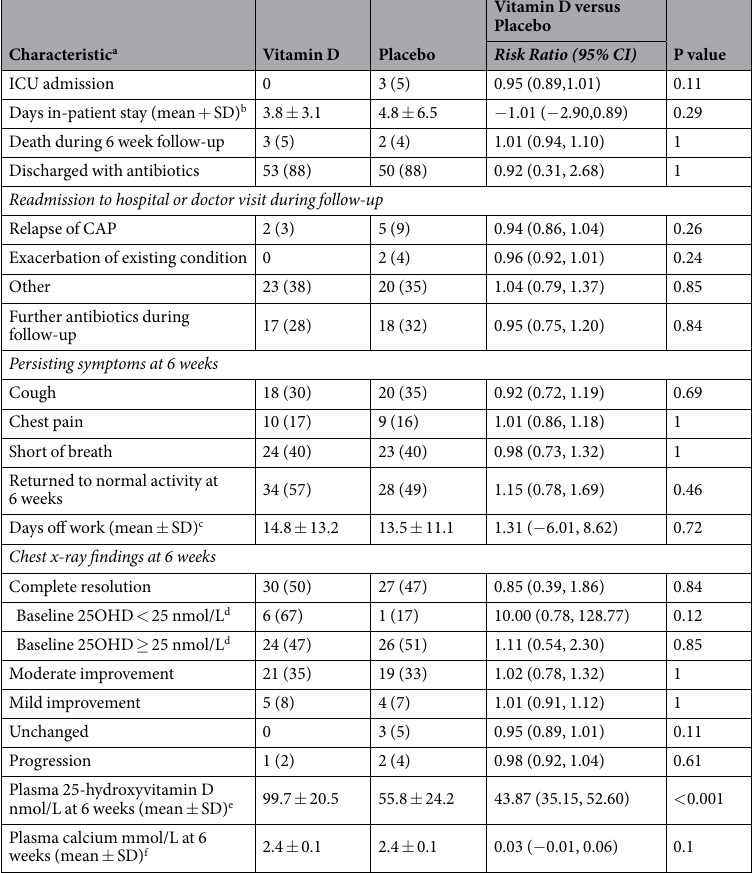
all patients received standard antimicrobial therapy for the treatment of CAP, which at Christchurch Hospital is based on the British Thoracic Society guidelines. Briefly, those patients with CURB-65 scores of 0 or 1 received monotherapy with a beta-lactam antibiotic (amoxicillin or amoxicillin-clavulanic, or cefuroxime for those with penicillin allergies), while those with a CURB-65 score 2 or greater, were given dual therapy of a beta-lactam and macrolide (azithromycin). The study treatment groups were evenly balanced on all characteristics except for pleural effusion. Plasma 25-OHD concentrations. nmol/L and 15 participants (n = 9 vitamin D; n = 6 placebo) had levels below 25 nmol/L. In the vitamin D group, average plasma 25OHD concentrations at 6 weeks post study treatment increased to 99.7 ± 20.5 nmol/L and was significantly higher than the placebo treatment group (55.8 ± 24.2 nmol/L; p = 0.05). Clearance of pneumonia and recovery. A total of 57 participants (49%; n = 30 vitamin D; n = 27 pla- cebo) had complete resolution of pulmonary inflammatory infiltrate on chest radiograph and were alive at 6 weeks post study treatment, with no significant difference between the two groups (Table 2). Stratifying by base- line 25OHD at 25 nmol/L showed no significant difference in either low or normal/high baseline vitamin D groups (Table 2). As a result of early termination, the study produced a dataset on 117 participants, sufficiently small to risk inflationary bias in estimates from logistic regression fitted with maximum likelihood 16 . To produce unbiased estimates the same model was refitted using an approximation to exact inference 17 which uses Markov chains